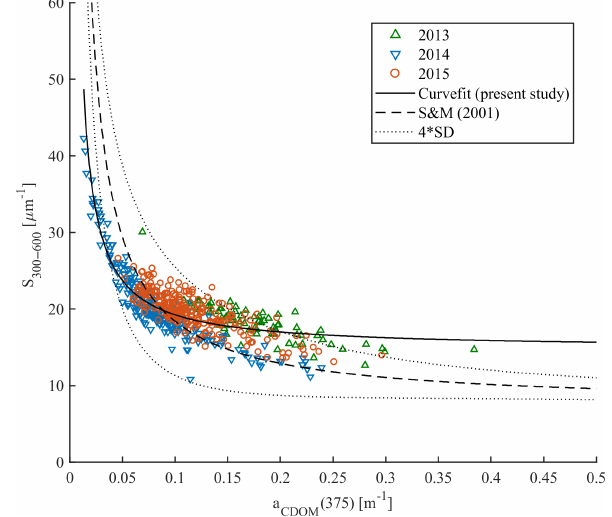
Figure 6. Spectral slope S 300–600 vs. a CDOM (375) in samples from 2013 (green triangles), 2014 (blue reversed triangles), and 2015 (red circles). The Stedmon and Markager (2001) model (dashed line) with model limits ( ± 4 standard deviation times the preci- sion of the S estimate; dotted line) adopted from the equation S = 7 . 4 + 11 /a CDOM (375). The solid line represents the modeled nonlinear fit for the present study data set.